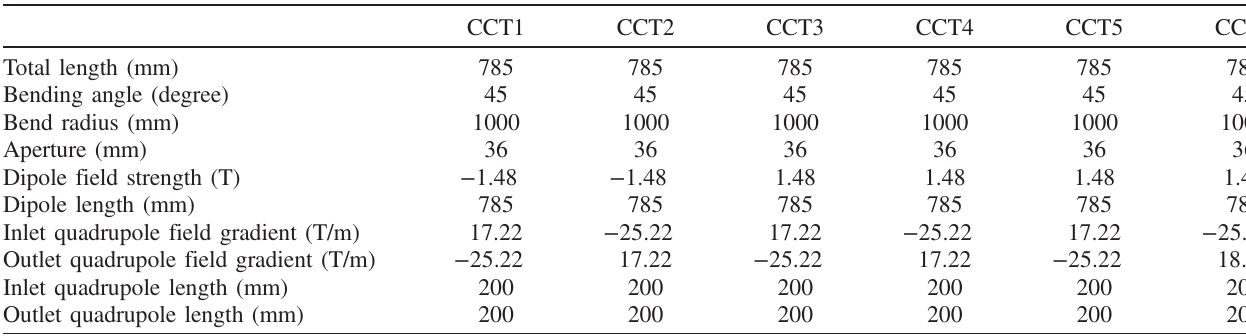
TABLE II. Main parameters of CCT